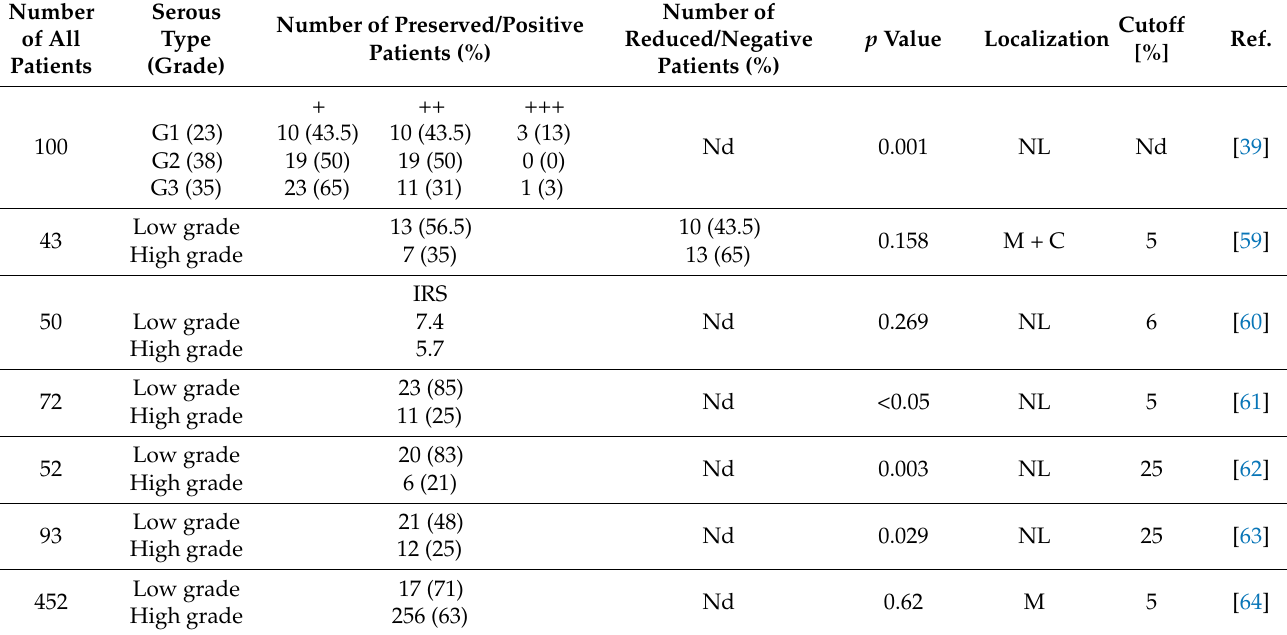
Table 5. The association of E-cadherin expression with grade of serous ovarian